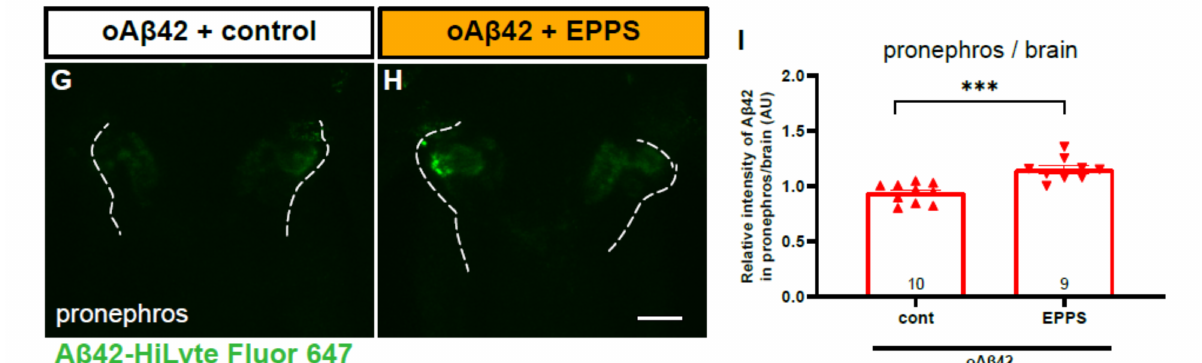
Figure 7. EPPS treatment enhances the BLEC localization and pronephric transport of oA β 42. ( A ) A schematic diagram of EPPS treatment after oA β 42 (HiLyte-Fluor 647) injection. Gray dotted box depicts the region of interest and blue lines indicate the pronephros. ( B – E ) Confocal images of prox1a:RFP+ BLECs in the loop of the optic tectum of oA β 42-injected larval brain with control ( B , D ) and EPPS treatment ( C , E ). ( B , C ) Co-localization of BLECs with oA β 42 increased upon EPPS treatment (arrows) in c compared to control ( B ). Scale bars in ( B , C ) = 50 µ m. ( D , E ) Confocal images of prox1a:RFP+ BLECs with EPPS treatment (250 mM, e ) after oA β 42 injection with high magnification revealed the internalized oA β 42 in BLECs compared to control ( D ). Scale bars in ( D , E ) = 5 µ m. ( F ) Quantification of oA β 42 co-localization in BLECs (%) upon EPPS treatment. Statistical significance was determined by ordinary one-way ANOVA with Tukey’s test. ( G , H ) Confocal images of the pronephros (white dotted lines) injected with oA β 42 in control ( G ) and with EPPS treatment for 24 h ( H ). ( I ) Quantification of the relative ratio of the intensity between the pronephros and brain. Two-tailed unpaired t -test, p = 0.0002. Data are presented as mean ± SEM. Data are representative of at least two independent experiments. Numbers within bar bottom graphs represent n . ***, p < 0.001; ****, p <